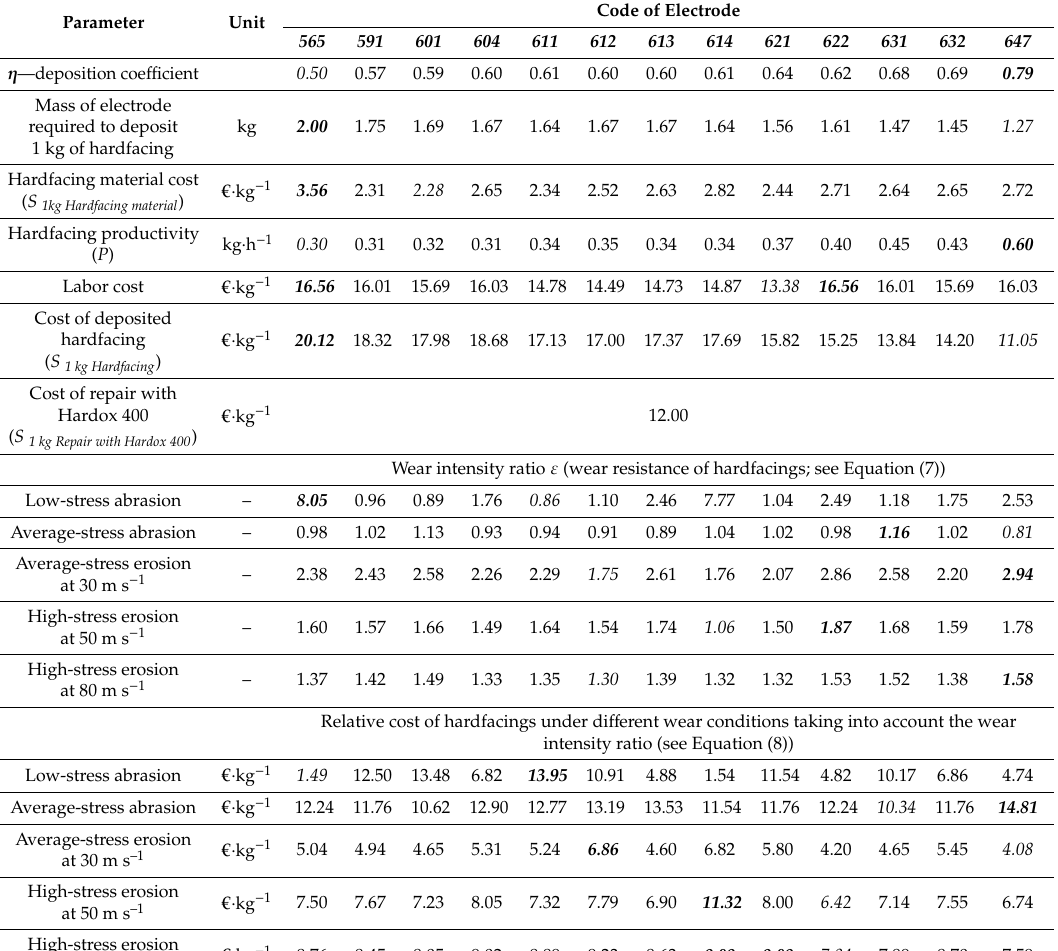
Table 5. Technical and economic indicators for the assessment of